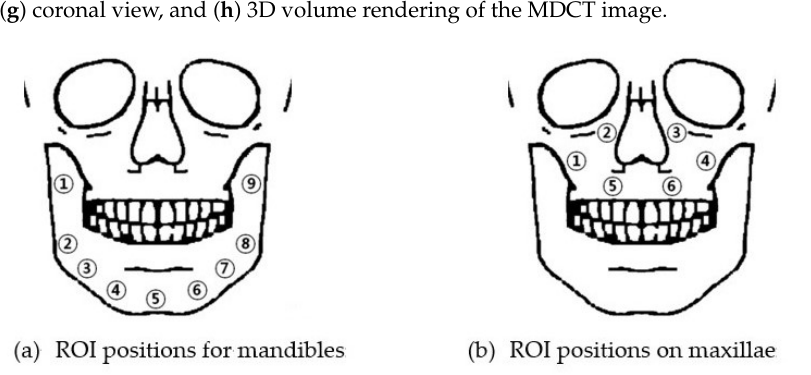
Figure 4. Reference positions of ROIs ( a ) on mandibles and ( b ) on maxillae.